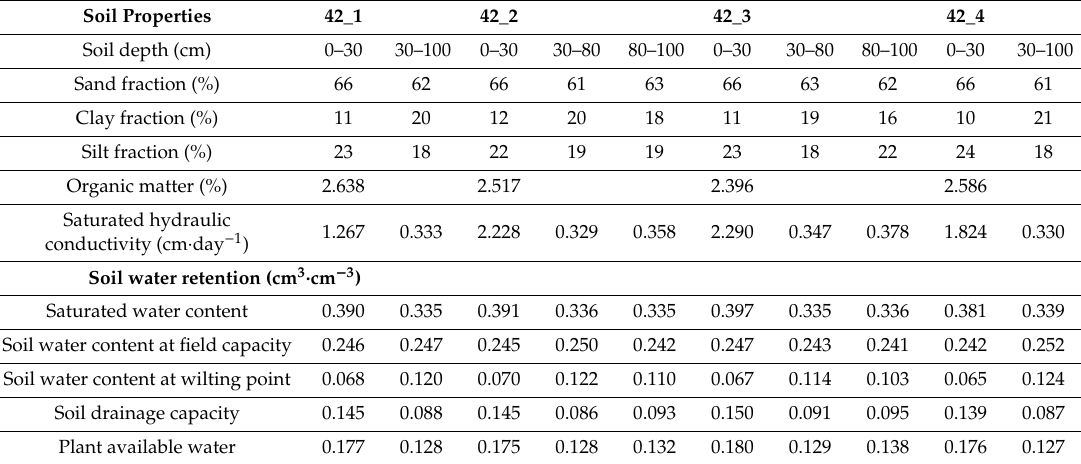
Table 1. Soil properties at the Ostrowo Szlacheckie